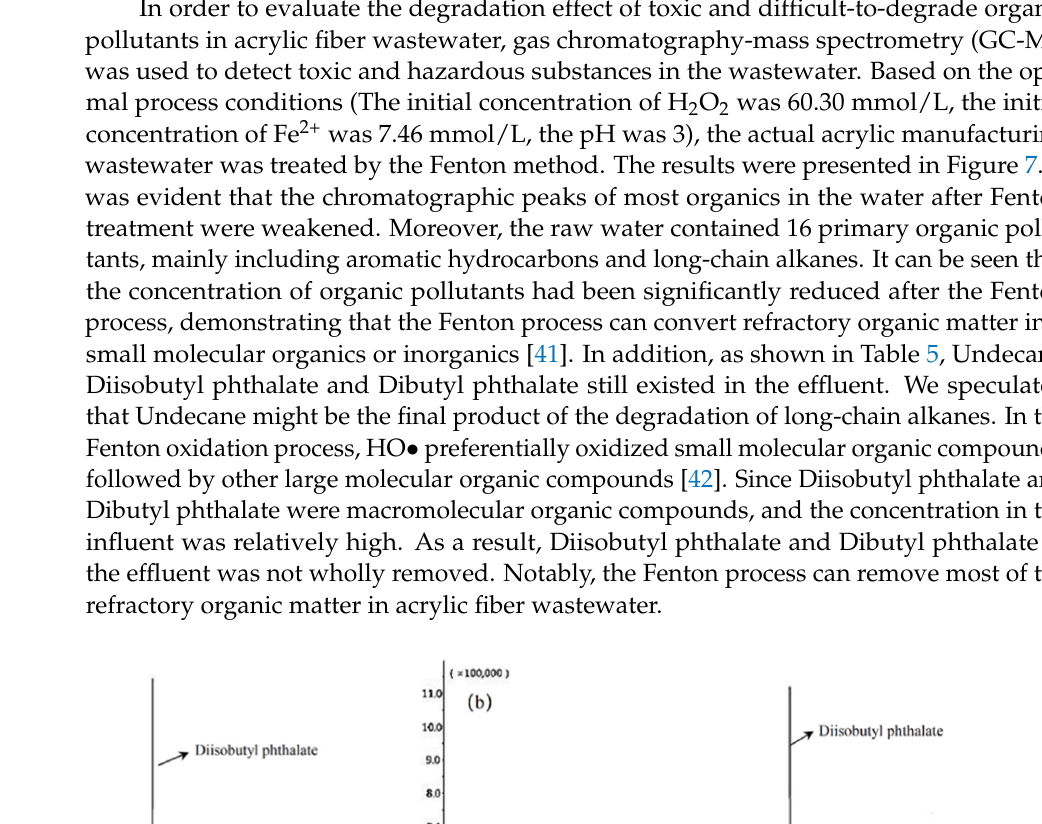
Table 4. Removing effect of acrylic fiber wastewater by Fenton process.